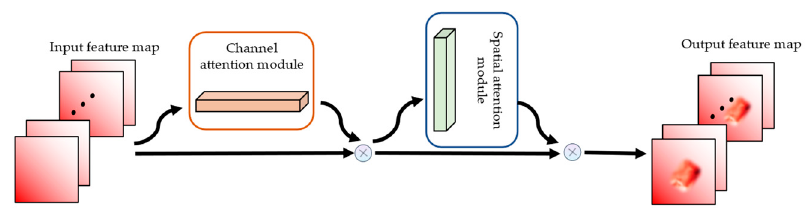
Figure 3. A chart of the convolutional block attention module.